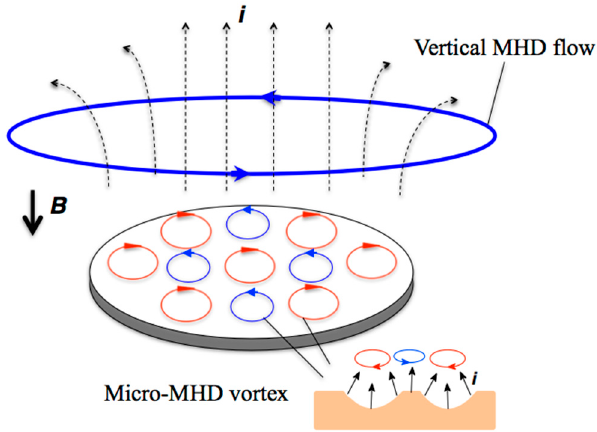
Figure 1. MHD effects in magnetoelectrochemical etching with vertical magnetic fields B . The Lorentz force acting on the ionic current i causes two types MHD flows; macroscopic vertical MHD flow around the electrode edge and micro-MHD vortices around the non-equilibrium fluctuations (pits) on the deposit surface.